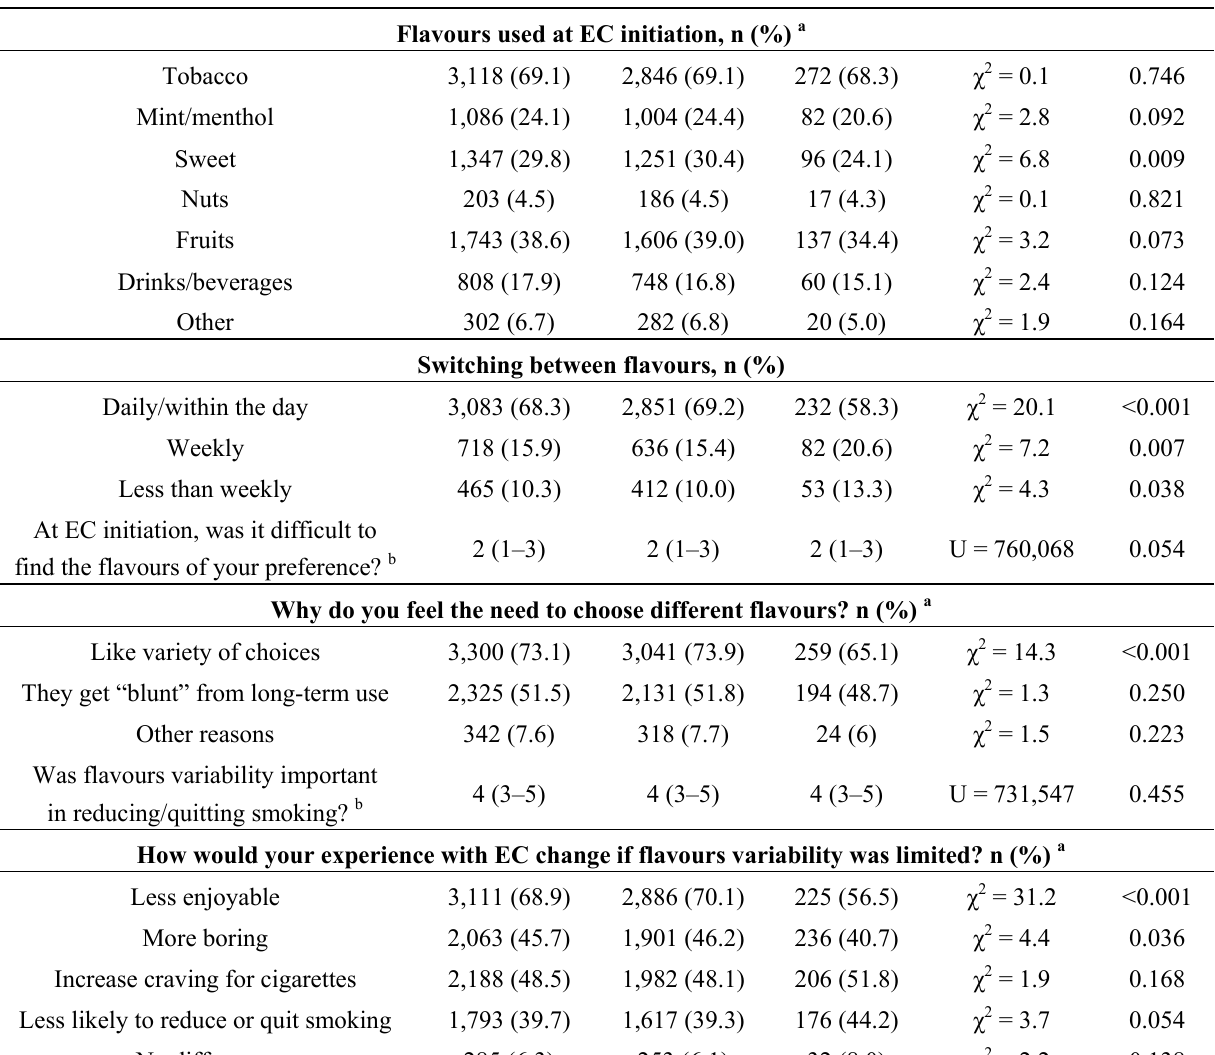
Flavours used at EC initiation, n (%)